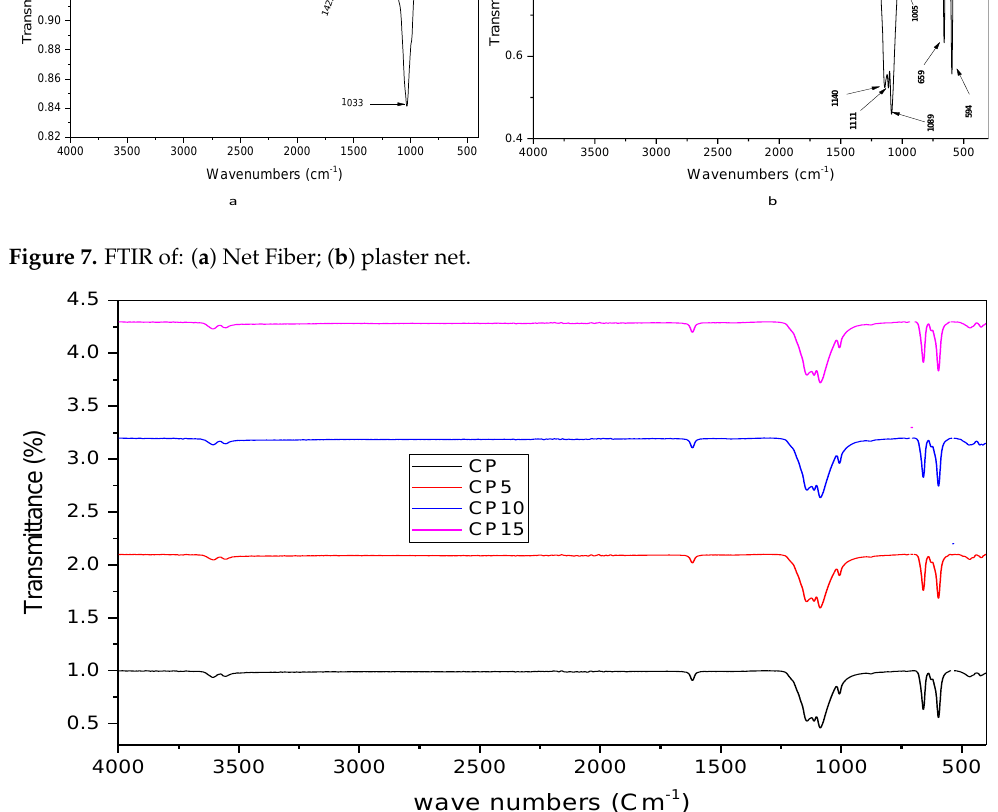
Figure 8. FTIR spectra of plasters before mixing and after